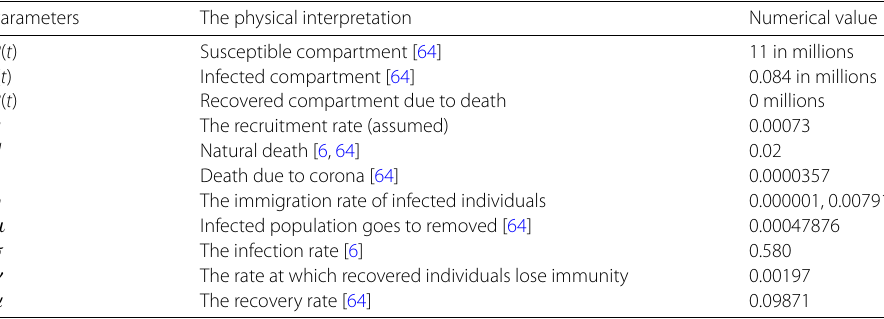
Table 2 Description of the parameters used in model (1) and their numerical values